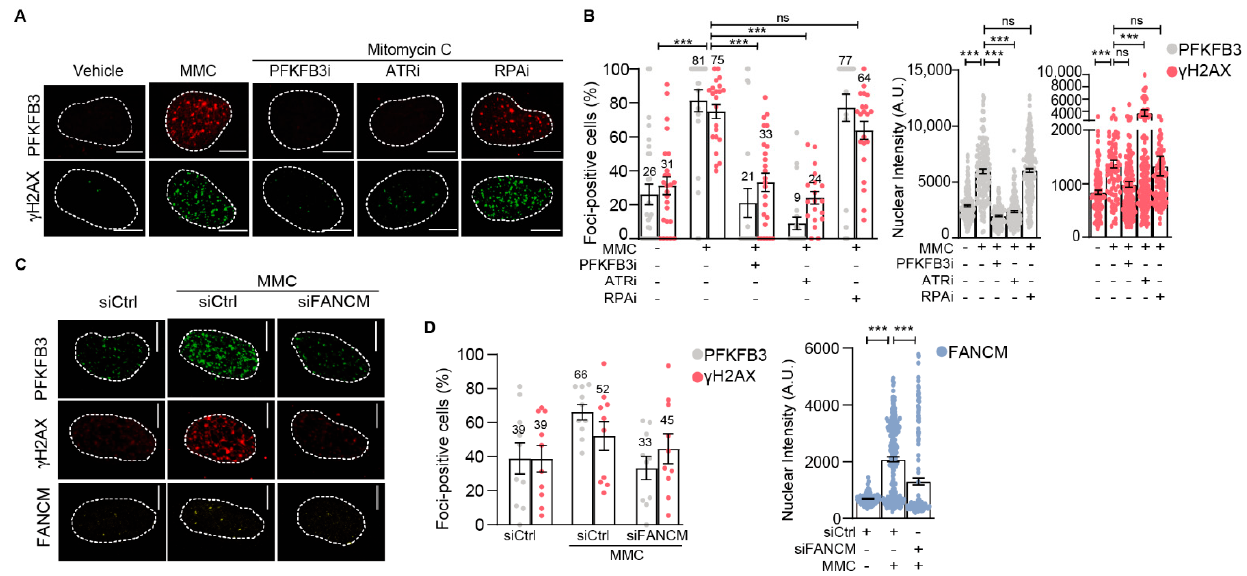
Figure 3. PFKFB3 requires ATR kinase activity for its nuclear recruitment to repair ICL-induced damage in replicating cells. ( A ) Representative confocal images of PFKFB3 and γ H2AX foci in U2OS cells synchronized at the G1/S boundary and released for 3 h in Mitomycin C (MMC, 360 nM) with or without PFKFB3i (10 µM), ATRi (2.5 µM), or RPAi (50 µM), n ≥ 2 independent experiments. Dotted lines indicate the nuclear border. Scale bar, 10 µm. ( B ) Scatter dot plot with bar charts of percentage PFKFB3 and γ H2AX foci positive cells upon image-based analysis of ( A ). Left panel shows the percentage of cells containing number of nuclear foci above the average in vehicle, data displayed as means ± S.E.M, one data point represents foci-positive percentage per image. Right graphs show nuclear intensity of PFKFB3 and γ H2AX stainings, data displayed as scatter dot plot with means ± S.E.M, one data point represents one cell. n ≥ 2 independent experiments, n > 100 cells per condition. *** p < 0.001; ordinary one-way ANOVA, Sidak’s test for multiple comparisons. ( C ) Representative confocal images of FANCM, PFKFB3, and γ H2AX foci in U2OS cells treated with siFANCM or siControl for 24 h, followed by cell cycle synchronization at the G1/S boundary and released into S-phase for 3 h in Mitomycin C (MMC, 360 nM) or left untreated, n > 2 independent experiments. Scale bar, 10 µm. ( D ) Quantification of FANCM, PFKFB3, and γ H2AX from ( C ) using CellProfiler. Left panel depicts the percentage of cells containing number of nuclear foci above the average in vehicle, data displayed as means ± S.E.M, one data point represents foci-positive percentage per picture. Right graph shows nuclear integrated intensity of FANCM. Data displayed as scatter dot plot with means ± S.E.M, one data point represents one cell. n > 2 independent experiments, n > 100 cells per condition. ** p < 0.01; ordinary one-way ANOVA, Sidak’s test for multiple comparisons.